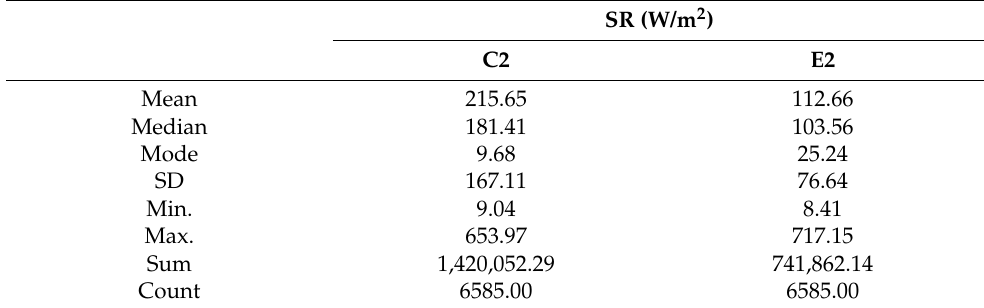
Table 4. Descriptive statistics of the SR in DLG (double-layered greenhouse). SR: solar radiation;